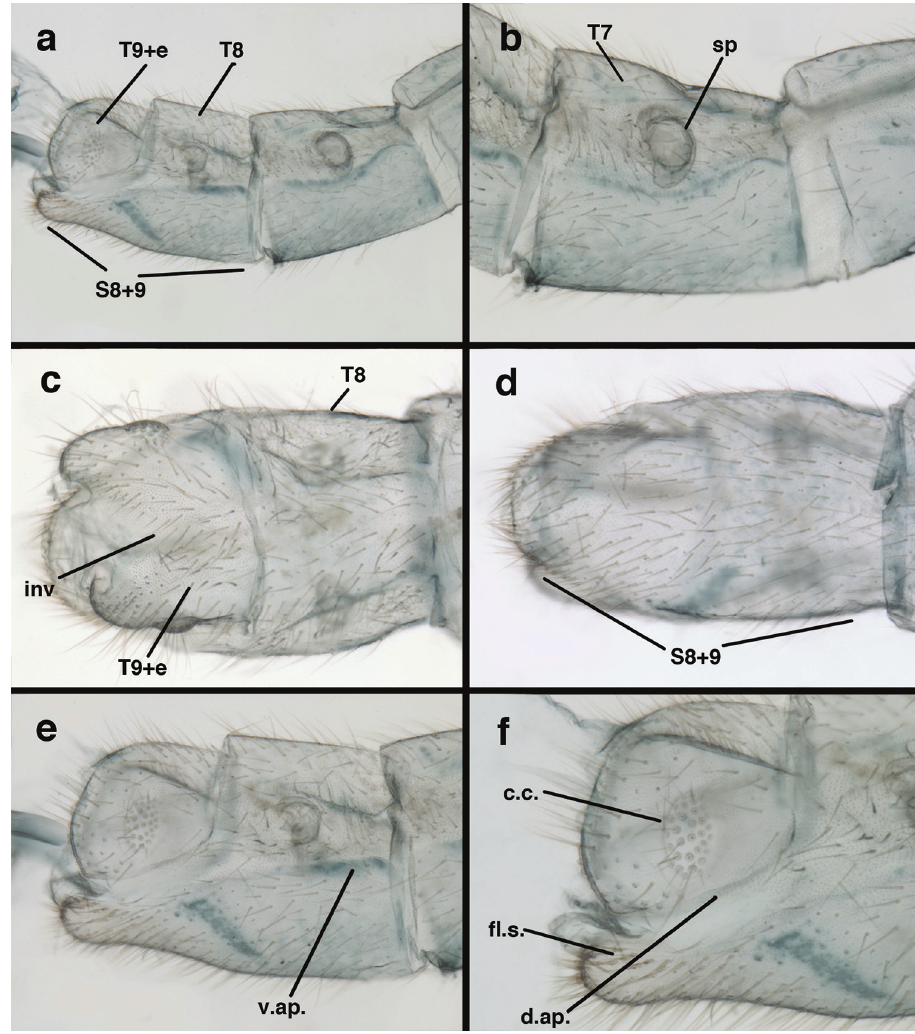
Figure 8. Ungla adamsi Tauber , sp. n. Slightly teneral male abdomen, ( a ) segments A7-terminus, lateral ( b ) segment A7 with enlarged spiracle, lateral ( c ) segments A8, A9+ectoproct, dorsal [Note deep mesal in- vagination of posterior margin.] ( d ) fused eighth and ninth sternites, ventral ( e ) segments A8-A9, lateral ( f ) terminus, lateral. c.c. callus cerci d.ap. dorsal apodeme (longitudinal apodeme along ventral margin of ectoproct) fl.s . flanged setae inv invagination of T9+ectoproct sp spiracle S8+9 fused eighth and ninth sternites T7 seventh tergite T8 eighth tergite T9+e fused ninth tergite and ectoproct v.ap. ventral apodeme (apodeme along dorsal margin of S8+9) (all: Peru, Machu Picchu, paratype, FSCA).